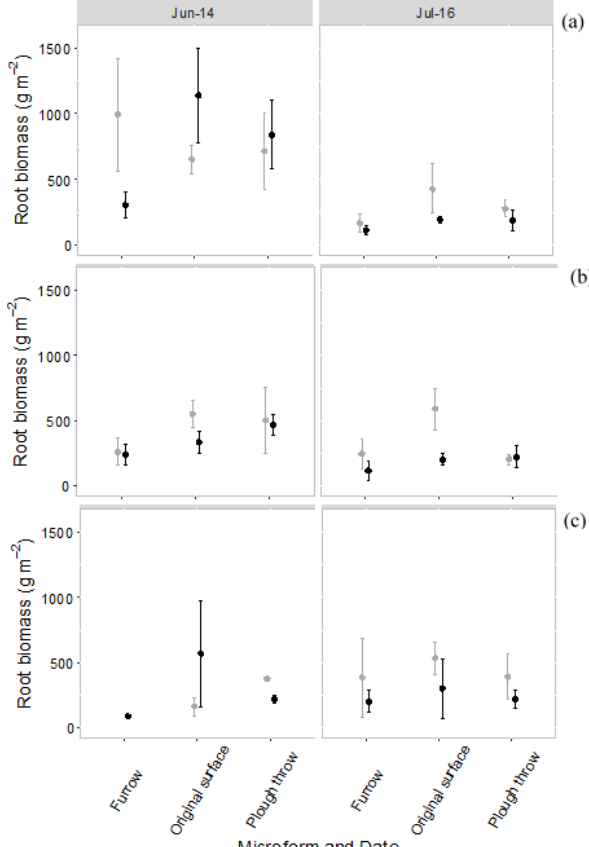
Figure 6. Root biomass per square meter to 25cm in control (grey) and trenched (black) plots at the beginning of the experiment (June 2014) and end of experiment (July 2016), split into three root size classes, per microform. (a) Root size < 2mm, (b) root size 2– 5mm and (c) root size > 5mm. Symbols are average fluxes with error bars representing standard errors ( n = 4